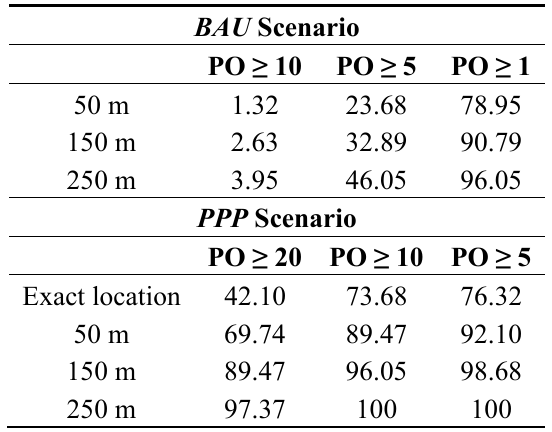
Table 1. Successful matching (%) between the reference parcels and the simulated possession as a function of the distance to the actual center of the reference parcels (lines) and to the possession occurrence (PO, rows), for the BAU and PPP scenarios. PO is the number of times one parcel is possessed among the 30